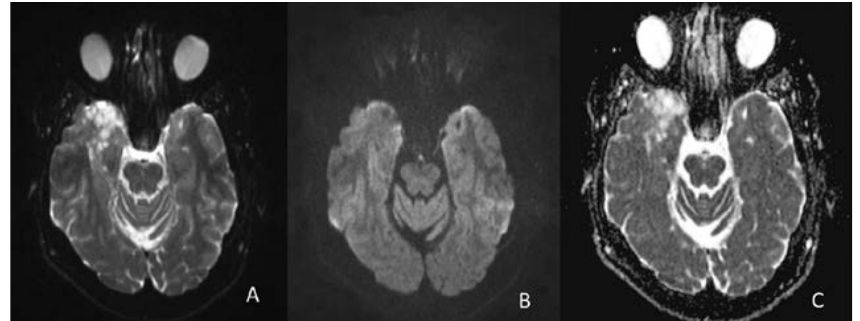
Figure 4. DWI ( A , B ) and ADC ( B ) in axial planes reveal the lesion with high signal intensity on DWI at b0 ( A ) and isointense at b800 ( B ) with high signal intensity on ADC ( C ), without restricted diffu- sion.